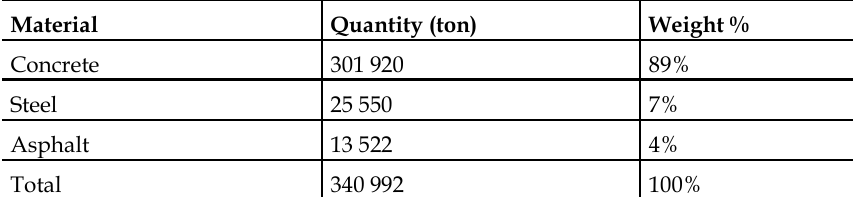
Table 3. Material quantities for the concrete tunnels in Norra Länken (2.5